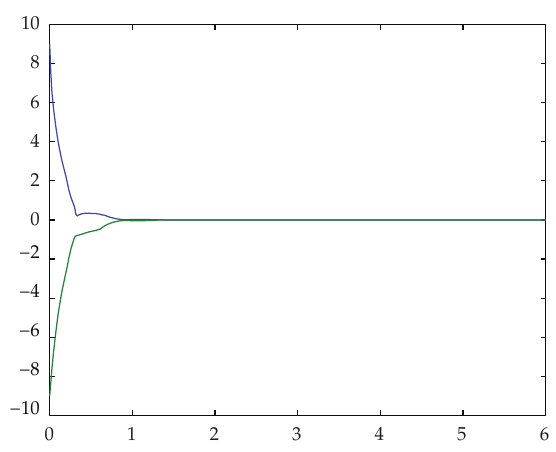
Figure 2: The state response without asynchronous switching.